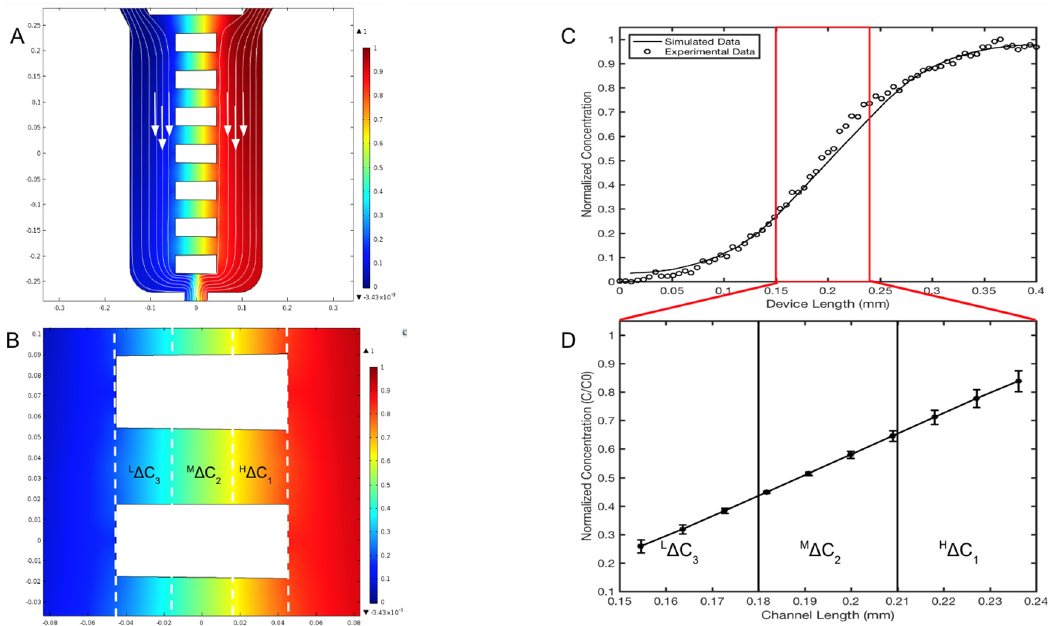
Figure 4. Concentration profiles generated within the μ OS system are defined precisely by analytical solutions to transport processes and experimentally validated via fluorescent microscopy. ( A ) Color-coded image of computationally predicted, steady-state concentration profiles within the microarray of the μ OS device. Red indicates the highest reagent concentration (C o ) and blue indicates the minimum (C = 0). White arrows indicate the direction of the flow. ( B ) Three regions of distinct concentrations within the microarray are marked as H Δ C 1 , M Δ C 2 , and L Δ C 3 . Three GM concentrations are established in the device of L Δ C 3 (150–180 μ m), M Δ C 2 (180–210 μ m), and H Δ C 1 (210–240 μ m) measured from the left boundary of the EID reservoir of the device. Each region measures roughly one-third of the microchannel length, L OS . ( C ) Concentration profile from the source to the sink reservoir of the μ OS device using a 20 kDa FITC–dextran tracer for experimental measurement (circles) alongside computational simulations (solid line). ( D ) The linear region between the vertical red lines corresponds to the concentration profile within the L OS segment lengths of the microchannel array.